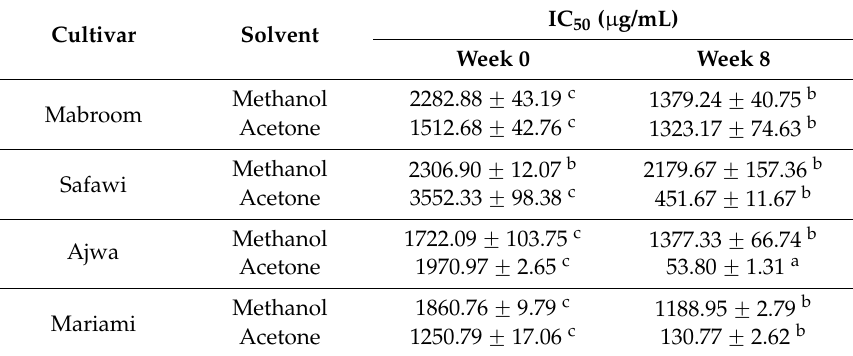
Table 2. Effect of fruit chilling at 4 ˝ C prior to extraction on IC 50 ( µ g/mL) in fruits of four P. dactylifera cultivars extracted using different